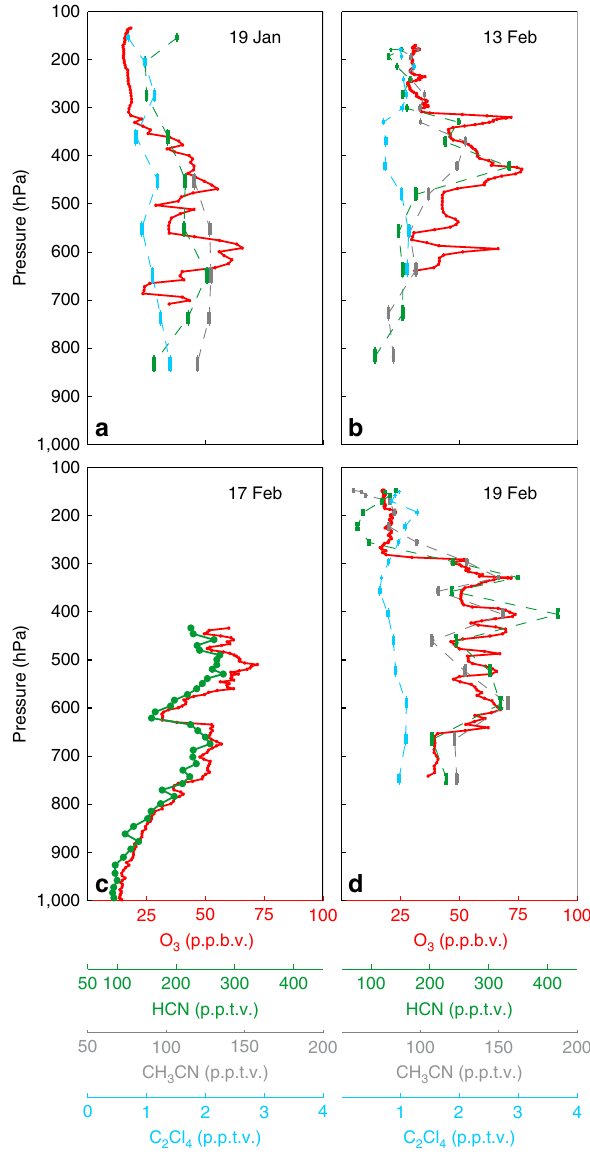
Figure 7 | Anthropogenic tracers in the HOLW structures. Sample profiles from CONTRAST ( a , b , d ) and CAST ( c ) from the four flights shown in Fig. 2. O 3 (red), CH 3 CN (grey), HCN (green) and C 2 Cl 4 (light blue) are shown. O 3 data are 10s averages. CH 3 CN and C 2 Cl 4 were not measured during CAST. CONTRAST HCN, CH 3 CN and C 2 Cl 4 were sampled for 35s at 2min intervals. CAST HCN was sampled for 30s. Vertical bars show the pressure range traversed during sampling.